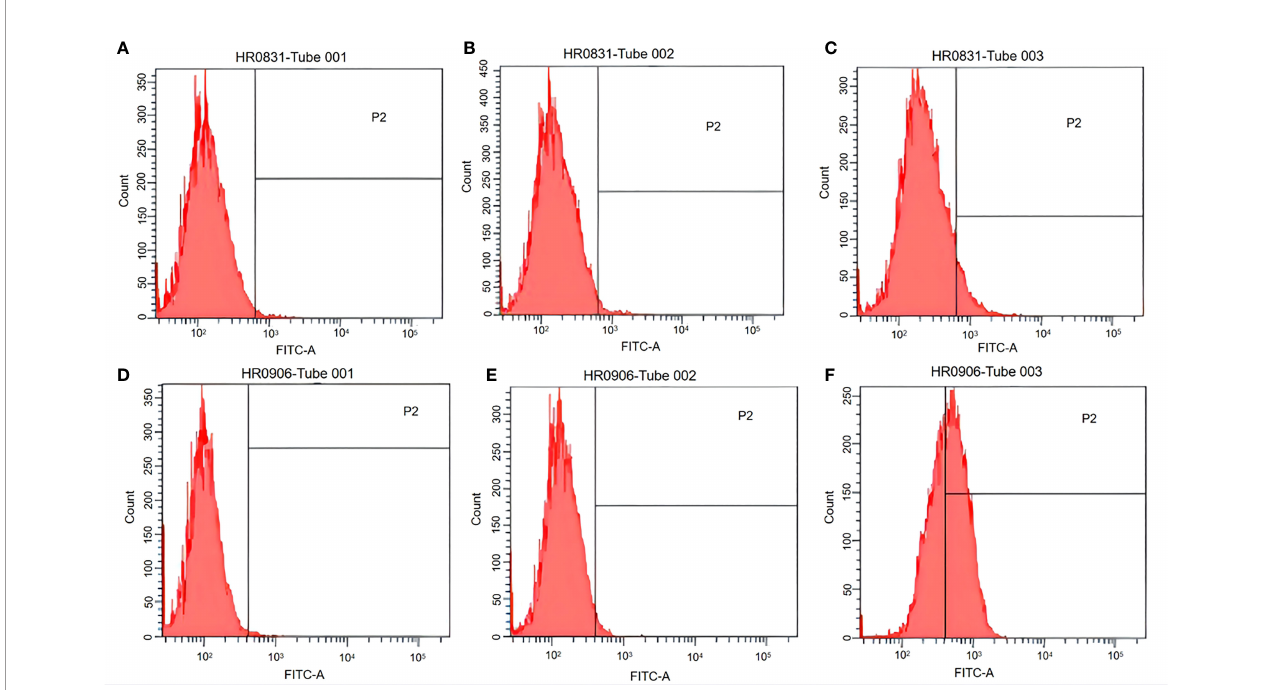
FIGURE 2 | EGFP expression in RAW264.7 cells and peritoneal macrophages was examined using fl ow cytometry. (A) Untreated RAW264.7 cells. (B) RAW264.7 cells incubated with pCI – EGFP (1 mg/mL). (C) RAW264.7 cells incubated with pCI – EGFP – loaded bacterial ghosts (BGs). (D) Untreated peritoneal macrophages. (E) Peritoneal macrophages incubated with pCI – EGFP (1 mg/mL). (F) Peritoneal macrophages incubated with pCI – EGFP – loaded